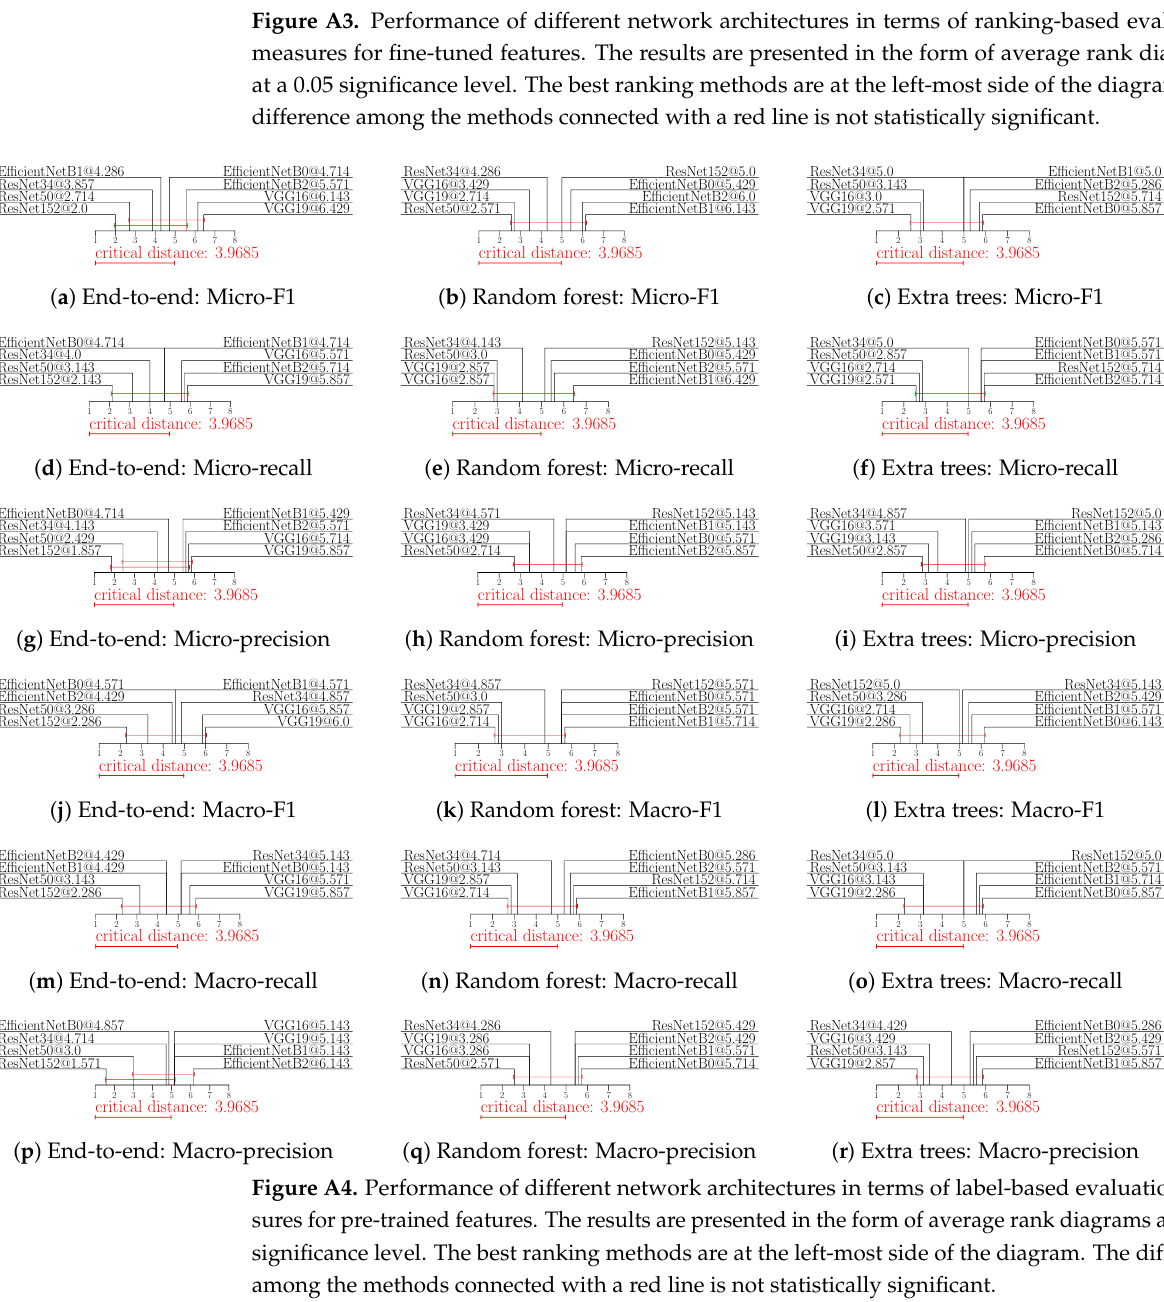
Figure A4. Performance of different network architectures in terms of label-based evaluation mea- sures for pre-trained features. The results are presented in the form of average rank diagrams at a 0.05 significance level. The best ranking methods are at the left-most side of the diagram. The difference among the methods connected with a red line is not statistically